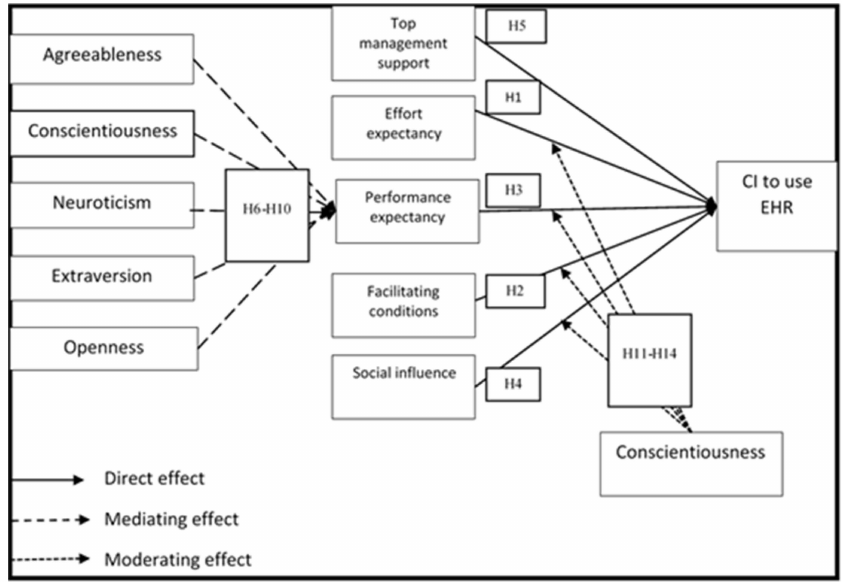
Figure 1. Theoretical Framework of the Relationship between the FFM, UTAUT Variables, Top Management Support, and Continuous Intention (CI) to Use Electronic Health Records